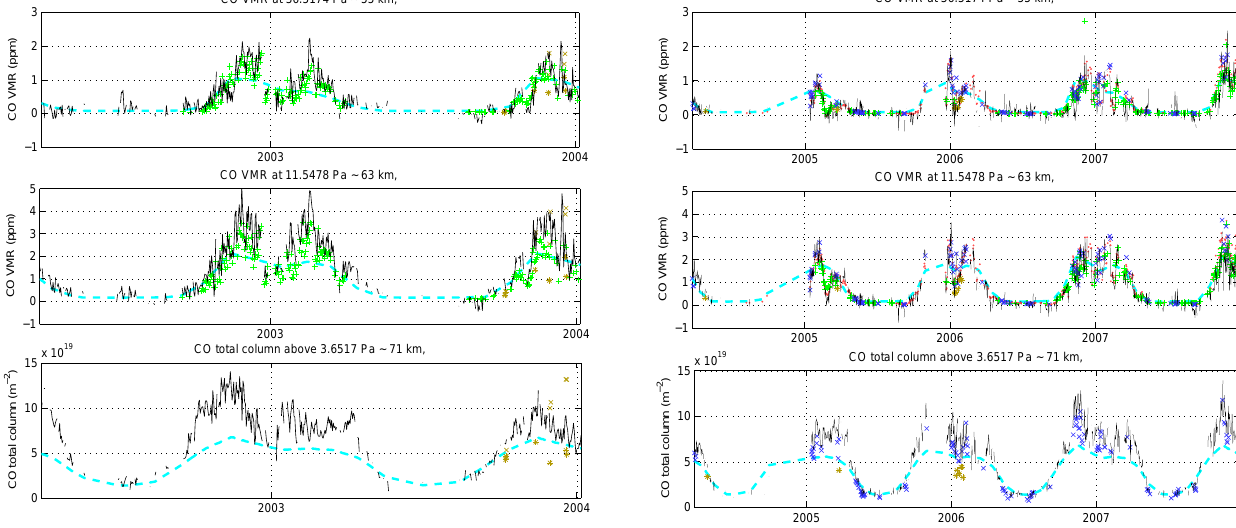
Fig. 10. Time series of CO mixing ratio at 55km and 63km and columns above 71km for the time period 2004–2008 are shown: OSO (black), FTS (blue cross), MIPAS (200, green plus), MLS (red dots), SMR (V225, brown stars) and a priori (cyan dashed).